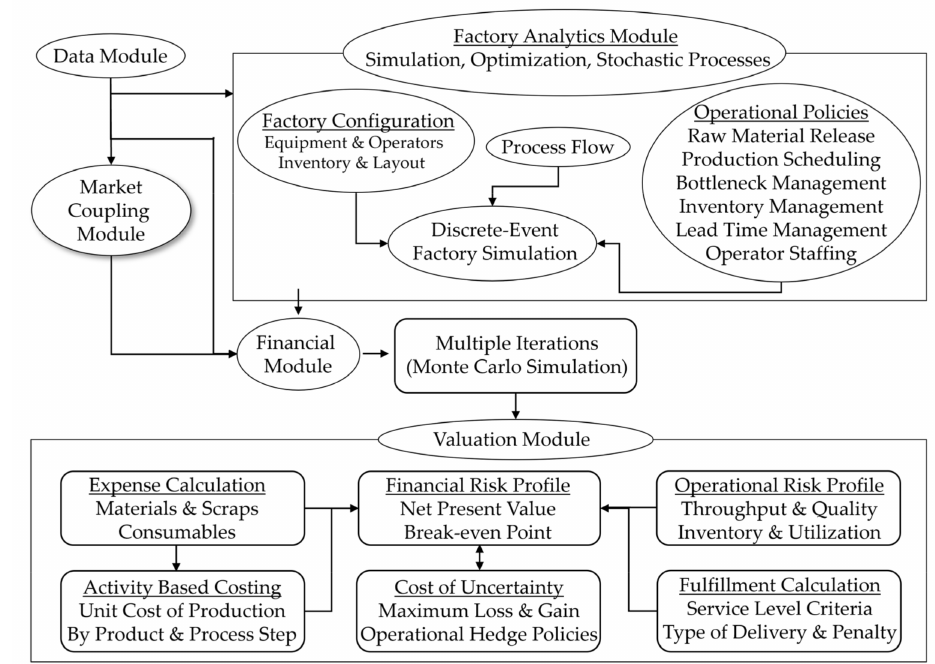
Figure 6. Primary modules of factory twin